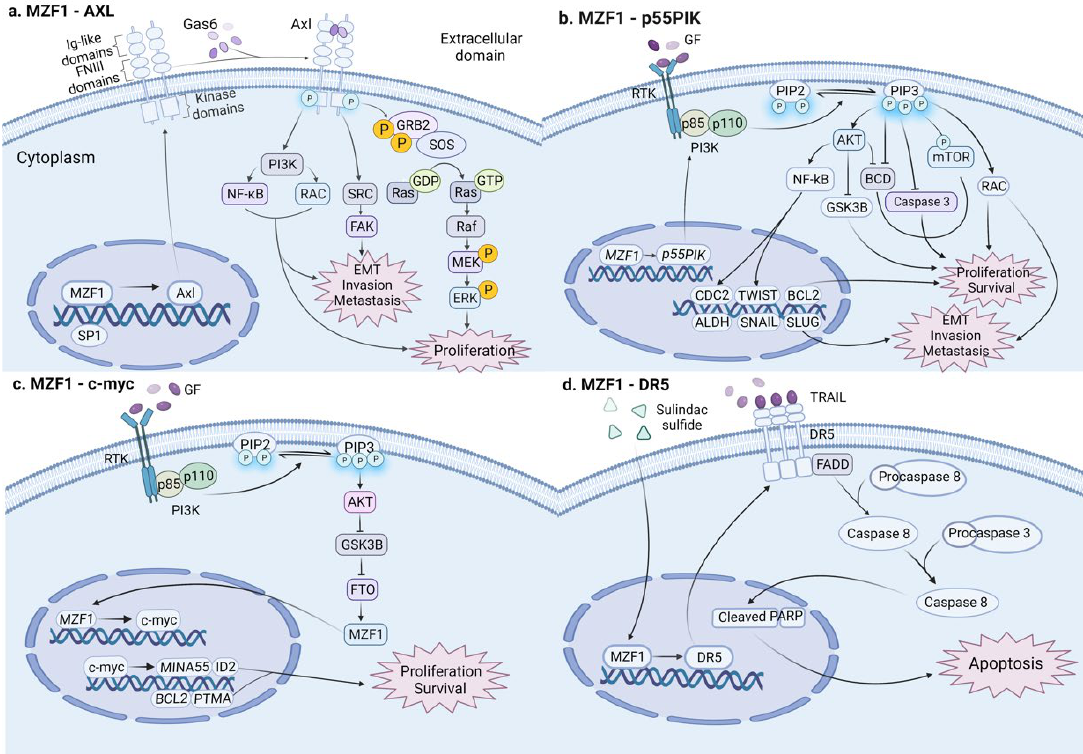
Figure 3. In colon cancer, MZF1 plays dual and opposite roles in different signaling pathways: ( a ) MZF1 transcriptionally activates the downstream target gene Axl and stimulates various signaling pathways, such as PI3K, FAK, Grb2/Ras, MEK/ERK, advancing cell proliferation, EMT transformation, invasion, and metastasis in colon cancer. ( b ) MZF1 transcriptionally activates the downstream target gene p55PIK; stimulates diverse signaling pathways such as PI3K/Akt and PI3K/RAC; and activates a series of downstream target genes such as CDC2, ALDH, BCL2, TWIST, SNAIL, and SLUG, promoting cell proliferation, EMT transformation, invasion, and metastasis in colon cancer. ( c ) MZF1 transcriptionally triggers the downstream target gene c-myc and multiple downstream target genes, such as MINA53, ID2, BCL2, and PTMA, promoting proliferation in colon cancer. ( d ) Sulfide sulindac sulfide induces the upregulation of MZF1. MZF1 promotes the expression of DR5 that interacts with FADD to activate caspases, promoting cell apoptosis and eventually inhibiting metastasis in colon cancer. (This figure was created with biorender. com.)